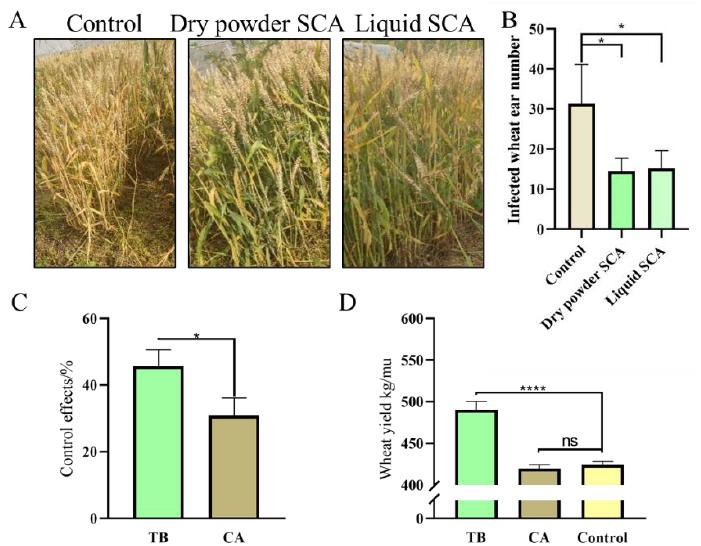
Figure 7. Effects of different types of seed-coating agent (SCA) on ( A , B ) number of wheat head blight-infected wheat ears in SJTU crop. The two types of SCA were prepared with the co-culture mixtures of T. atroviride SG3403 and B. subtilis 22. Effects of Trichoderma – Bacillus SCA on ( C ) control of wheat head blight and ( D ) wheat production in ZAAS. TB denotes the seed-coating agent of T. atroviride SG3403 and B. subtilis 22 co-culture mixtures and CA denotes the 50% carbendazim. The co-culture seed-coating agent of Trichoderma and Bacillus showed a synergistic effect on the control of wheat head blight and could also improve wheat production. T. atroviride SG3403 and B. subtilis 22 had a better effect together. * represents significant differences between the treatment and control ( p < 0.05). **** represents significant differences between the treatment and control ( p < 0.001). “ns” represents non-significant differences between the treatment and